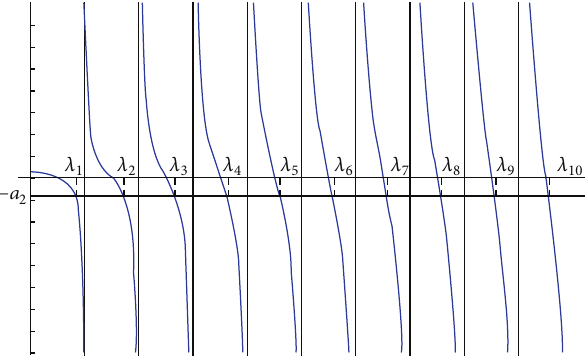
Figure 1: Graphical representation of 𝑦 = 𝜆 cot (𝜆) and determina- tion of the eigenvalues 𝜆 𝑛 for −𝑎 2 < 0